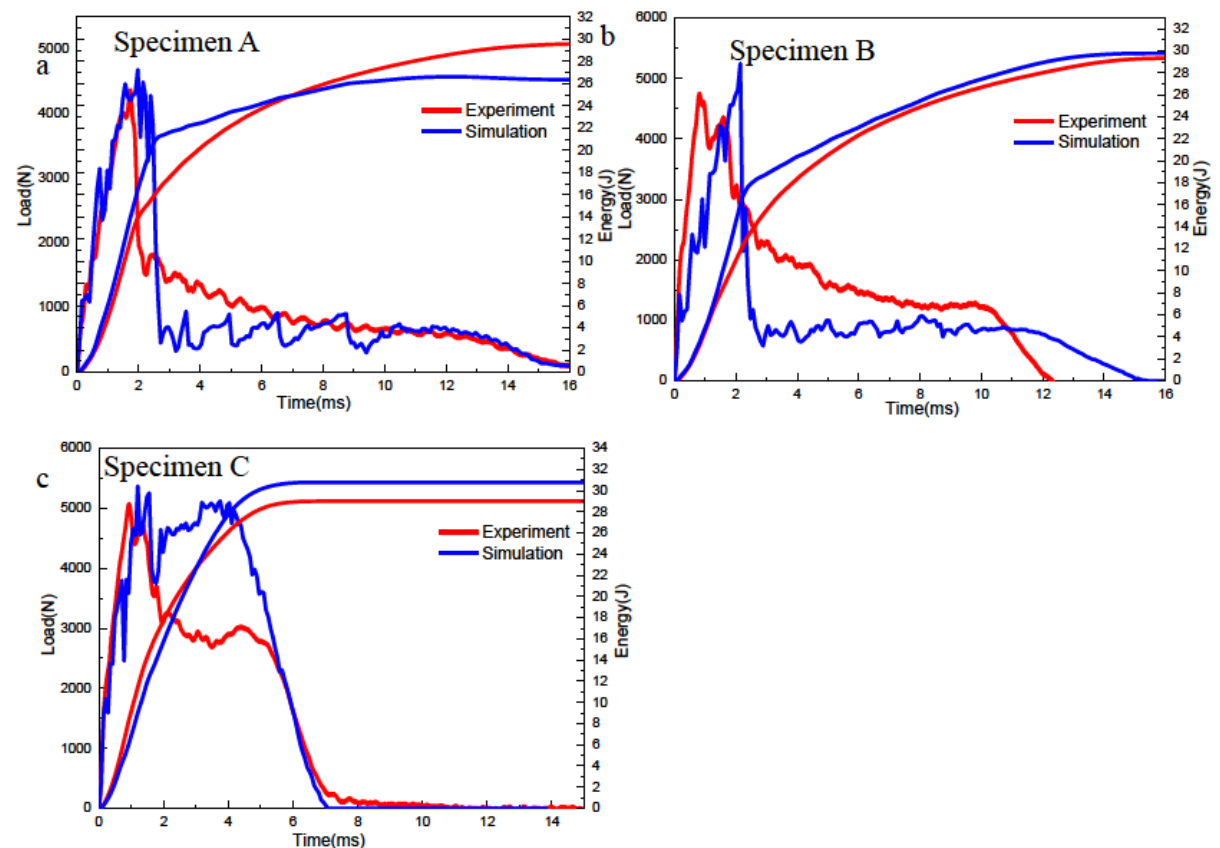
Figure 7: Response of specimens impacted under the impact energy of 30 J.